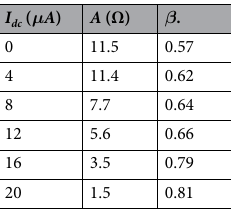
Table 2. Fit parameters obtained for power law fits, see Fig. 3(b), of the amplitude of the oscillatory magneto- resistance induced by photo-excitation at different I dc